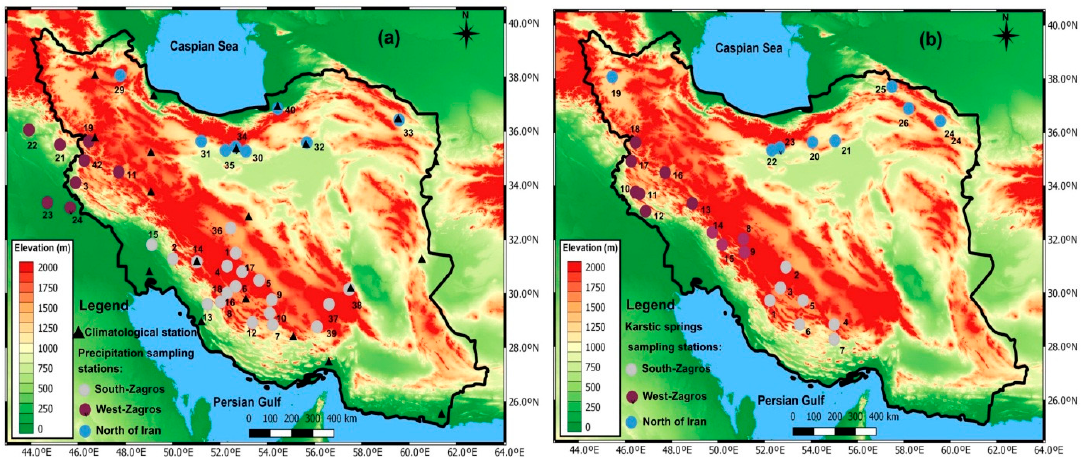
Figure 2. Climatological stations (black triangles) and precipitation sampling sites for isotope composition of hydrogen ( δ 2 H) and oxygen ( δ 18 O) analysis in North Iran (sky blue circles), West Zagros (brown circles) and South Zagros (gray circles) ( a ). Karstic springs sampling sites for isotope composition of hydrogen ( δ 2 H) and oxygen ( δ 18 O) analysis in Iran (b) . The geographic location, boundaries of Iran (black line), and elevation map are derived from the Hydrosheds project [58].